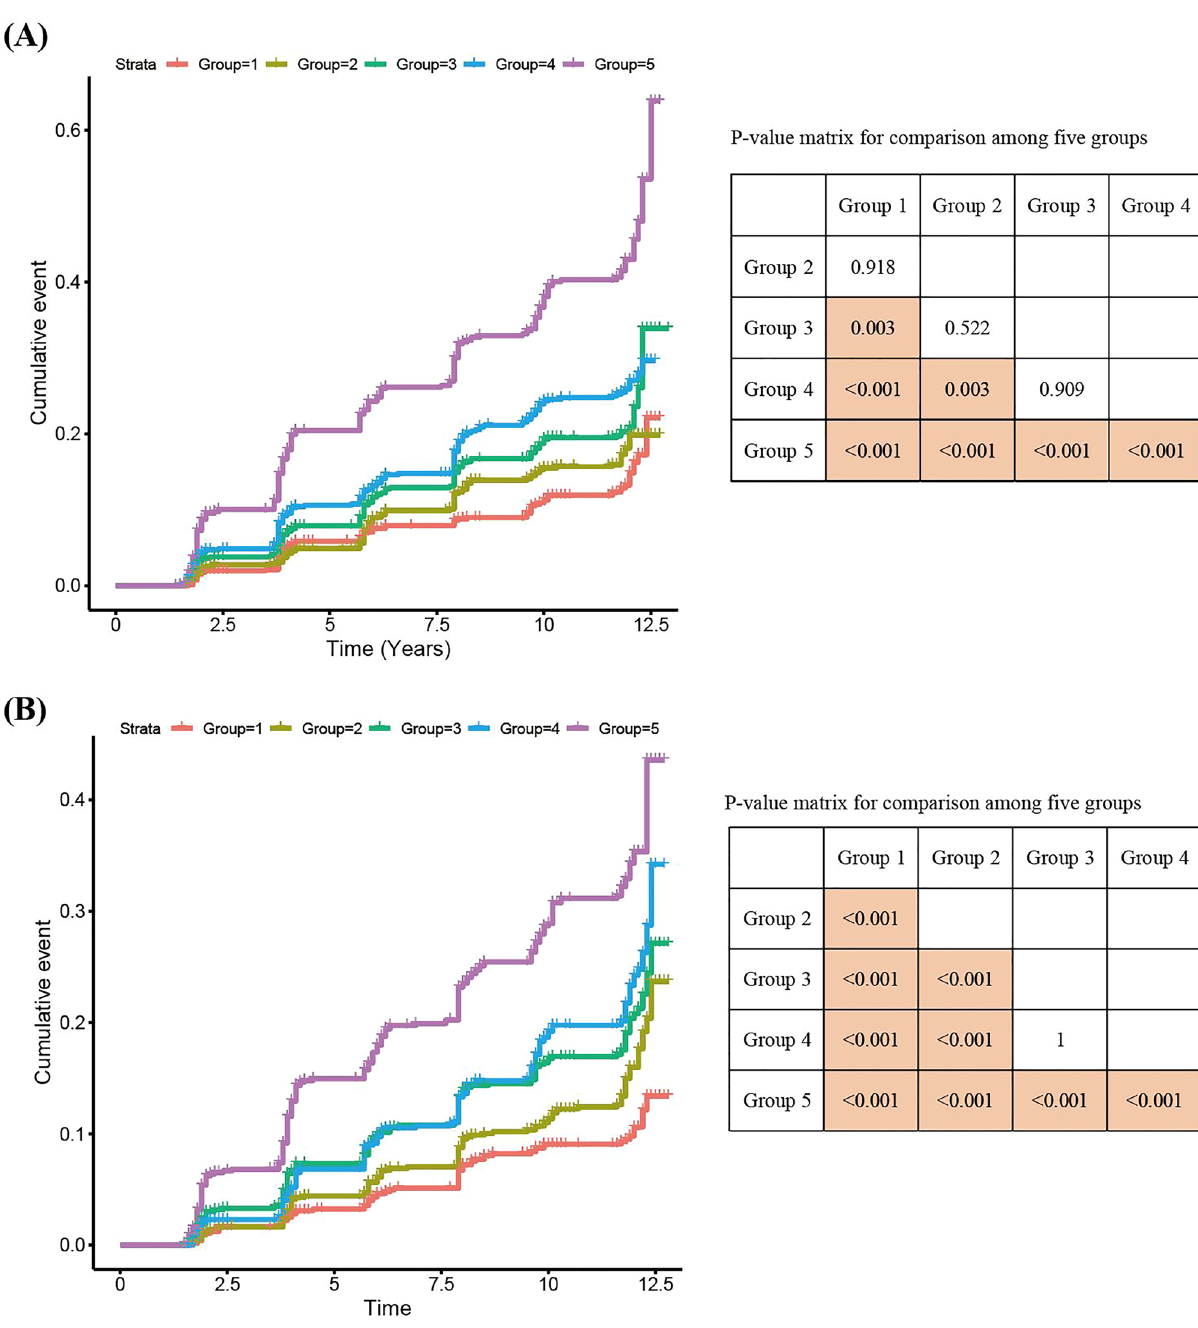
Figure 2. Cumulative incidence difference of new-onset diabetes between five groups, divided according to the expected probabilities of participants in the KoGES study. Group 5 showed highest cumulative incidence in these five groups of both ( A ) men, ( B ) women. KoGES Korean Genome and Epidemiology